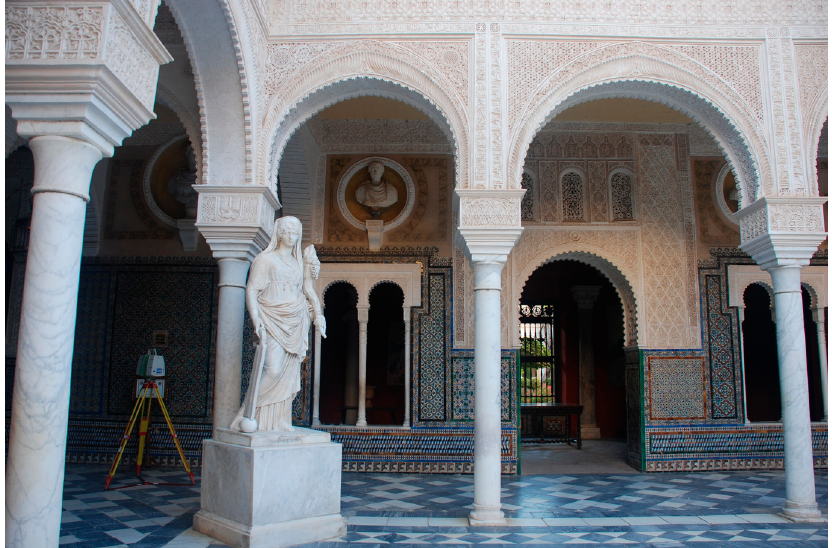
Figure 1. View of the main patio of Casa de Pilatos.